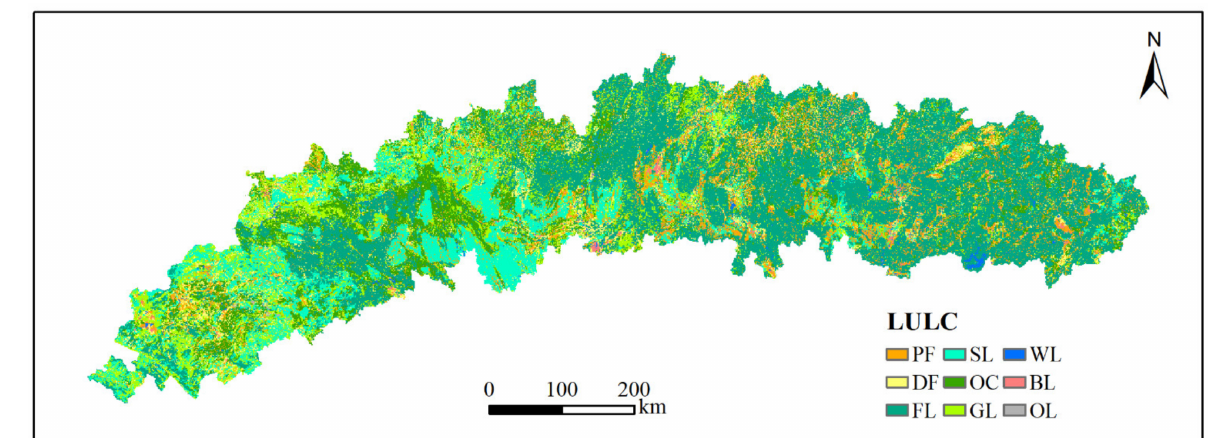
Figure 2. Spatial distribution of LULC in the